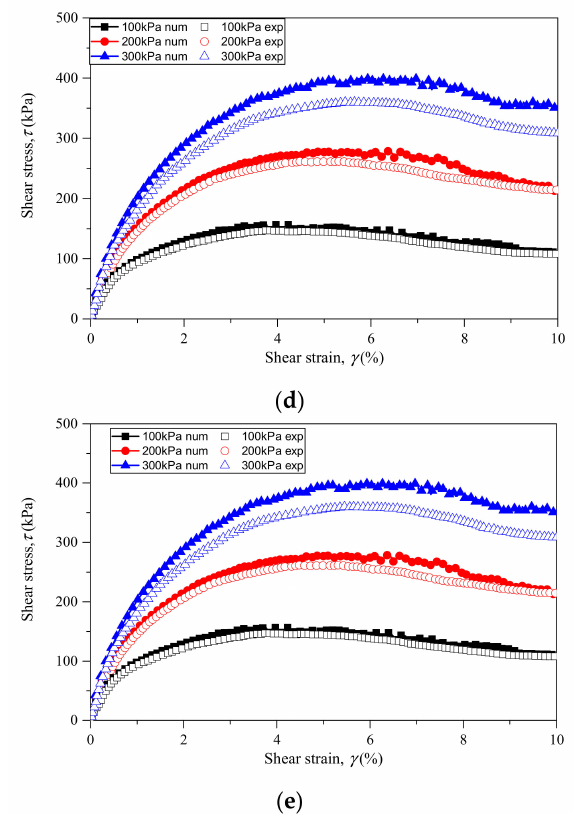
Figure 7. Stress–strain behavior of sand–RCA mixtures under different confining stresses with RCA